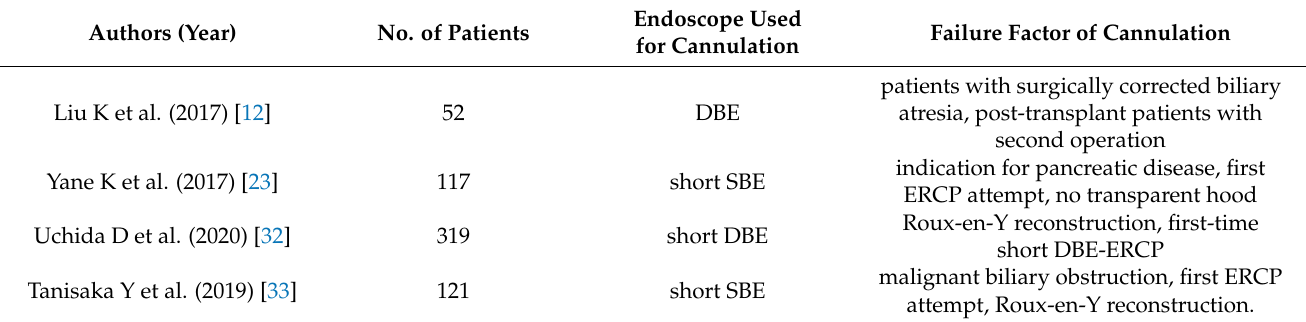
Table 6. Outcomes of previous reports on the association between BE-ERCP and related clinical factors. Endoscope Used Authors (Year) No. of Patients Failure Factor of Cannulation patients with surgically corrected biliary DBE atresia, post-transplant patients with second operation indication for pancreatic disease, first short SBE ERCP attempt, no transparent hood Roux-en-Y reconstruction, first-time 319 short DBE short DBE-ERCP malignant biliary obstruction, first ERCP short SBE attempt, Roux-en-Y